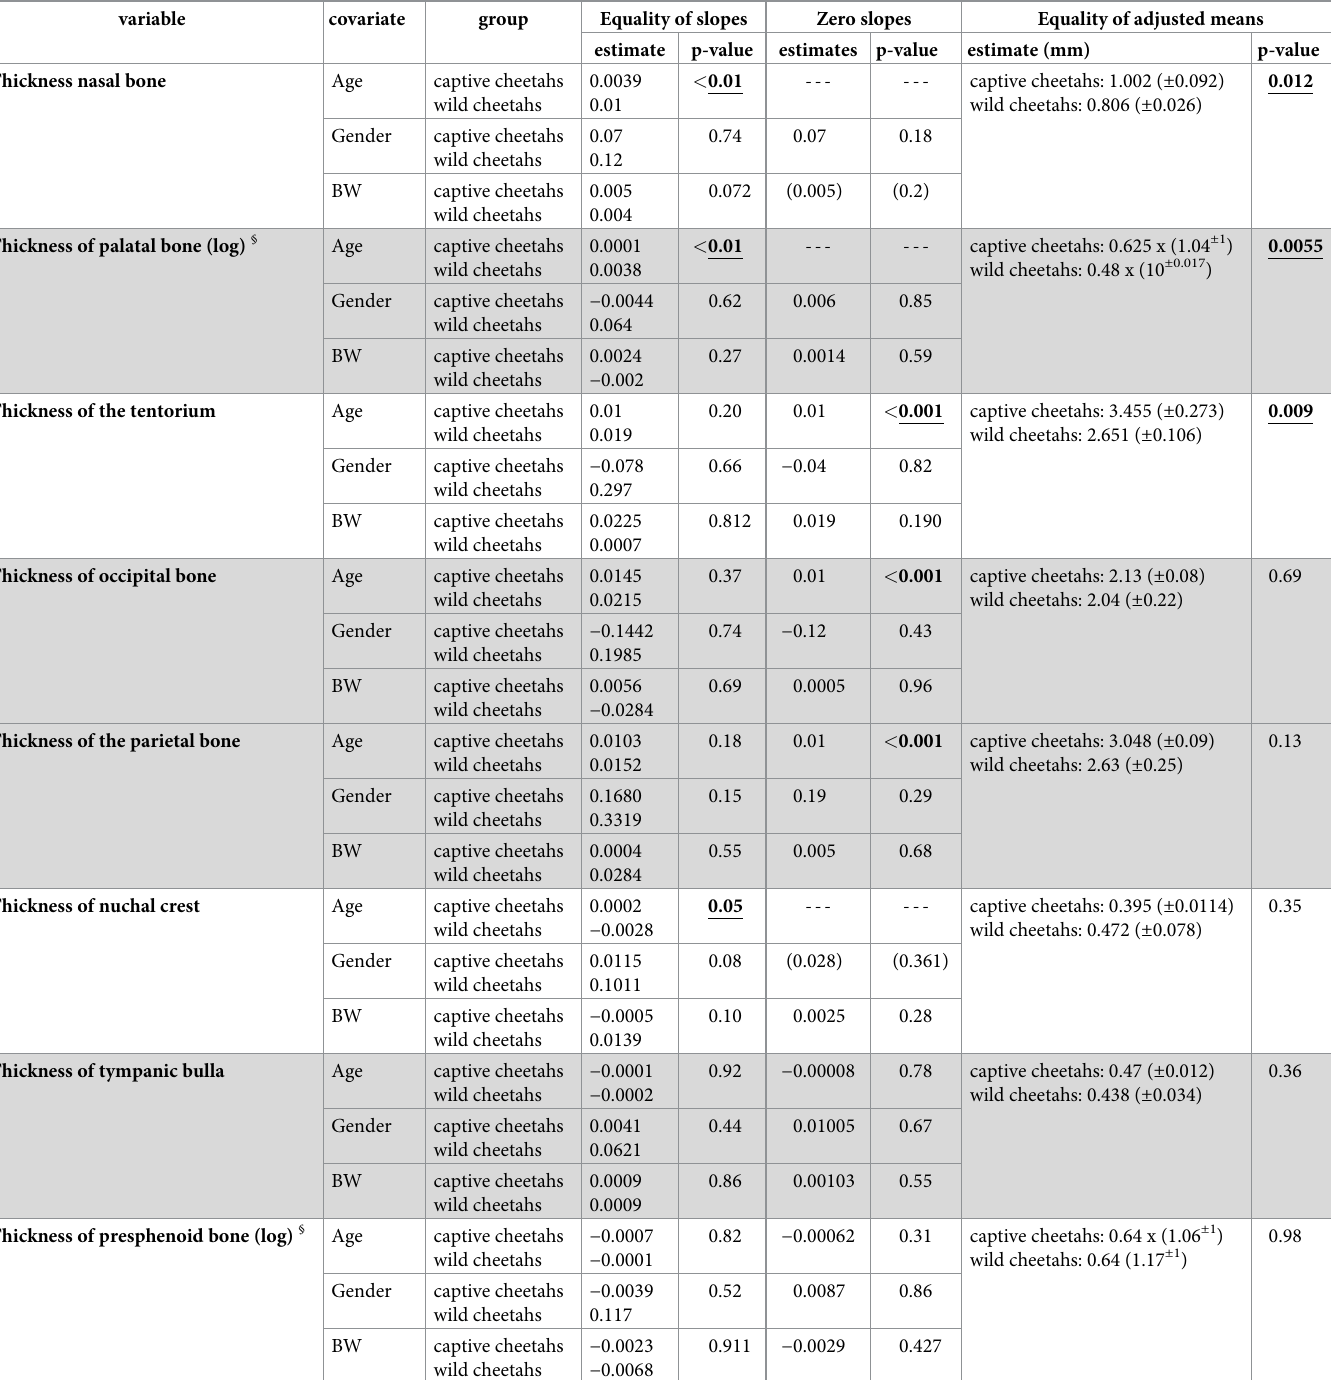
Table 1. Results of the one-way analysis of covariance and comparison of bone thickness in captive and wild